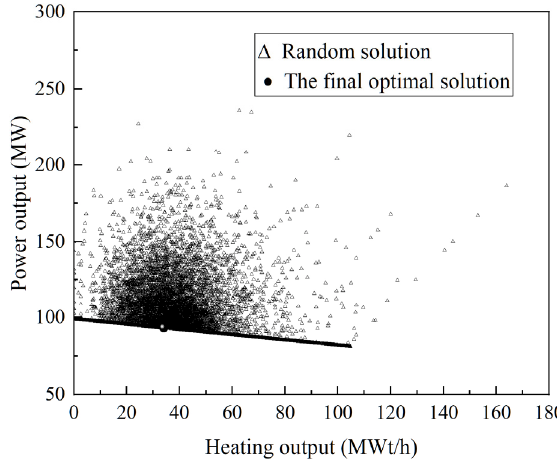
Figure 6. The individual optimization trace of cogeneration unit 5 with Levy–GWO algorithm.